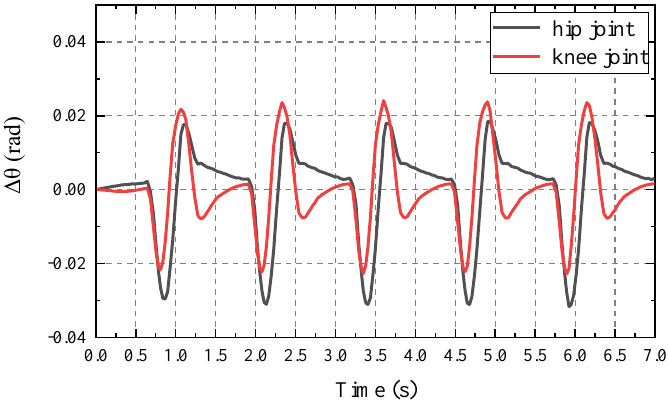
Figure 15. Tracking error of the leg 1 joints.